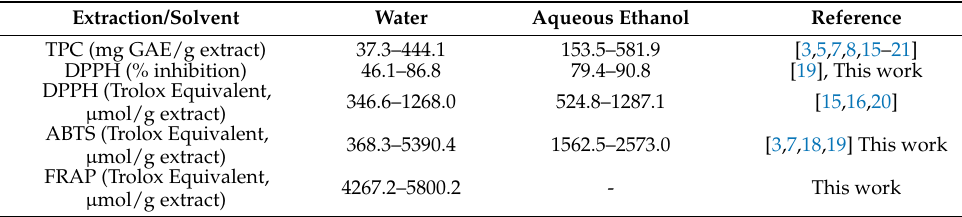
Table 3. Effect of extraction method on antioxidant capacity of pecan shell extracts.